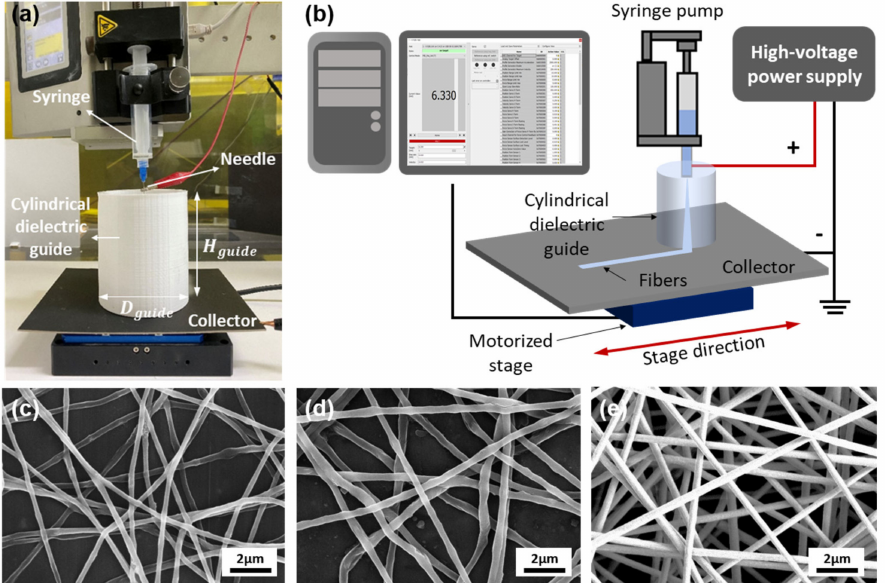
Figure 3. ( a ) Focused patterning setup with cylindrical dielectric guide; ( b ) electrospinning schematic; and ( c – e ) SEM images of ( c ) polyacrylonitrile (PAN); ( d ) polyethylene oxide (PEO); and ( e ) polyurethane (PU) nanofibers.